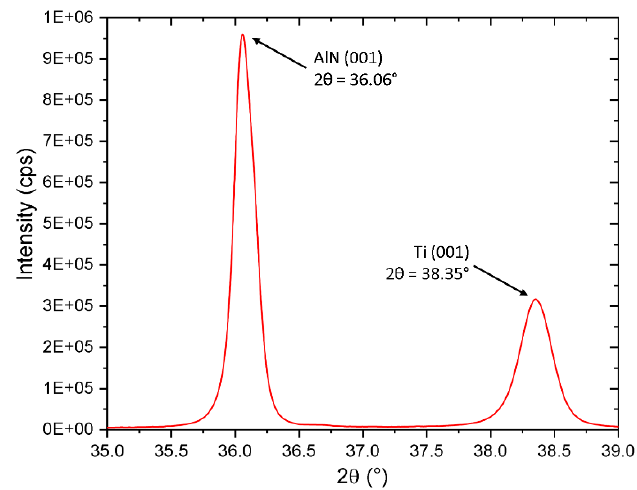
Figure 4. X-ray diffractogram determined using Brag-Brentano setup showing 2 θ peak positions of Ti (001) ≈38.35° and AlN (001) ≈36.06°.